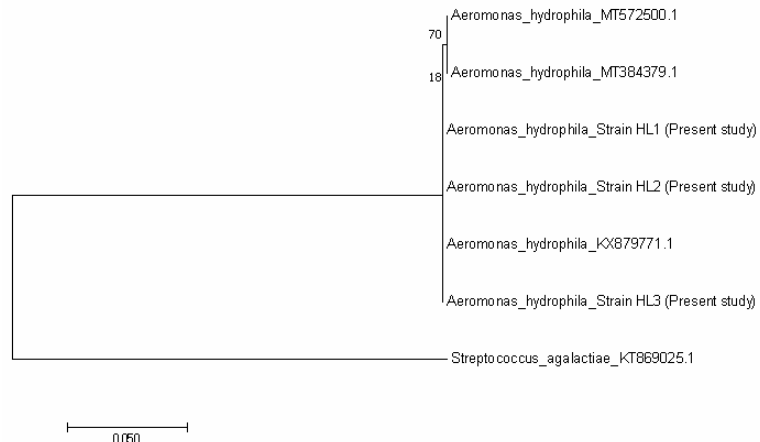
Figure 6. Phylogenetic tree showing the relationship between the three Aeromonas hydrophila sequences from the present study, with other reference sequences from Algeria (MT572500.1), India (MT384379.1) and Iran (KX879771.1). The tree is based on the 683 bp 16S rRNA gene of A. hydrophila . Streptococcus agalactiae was considered as an out group.